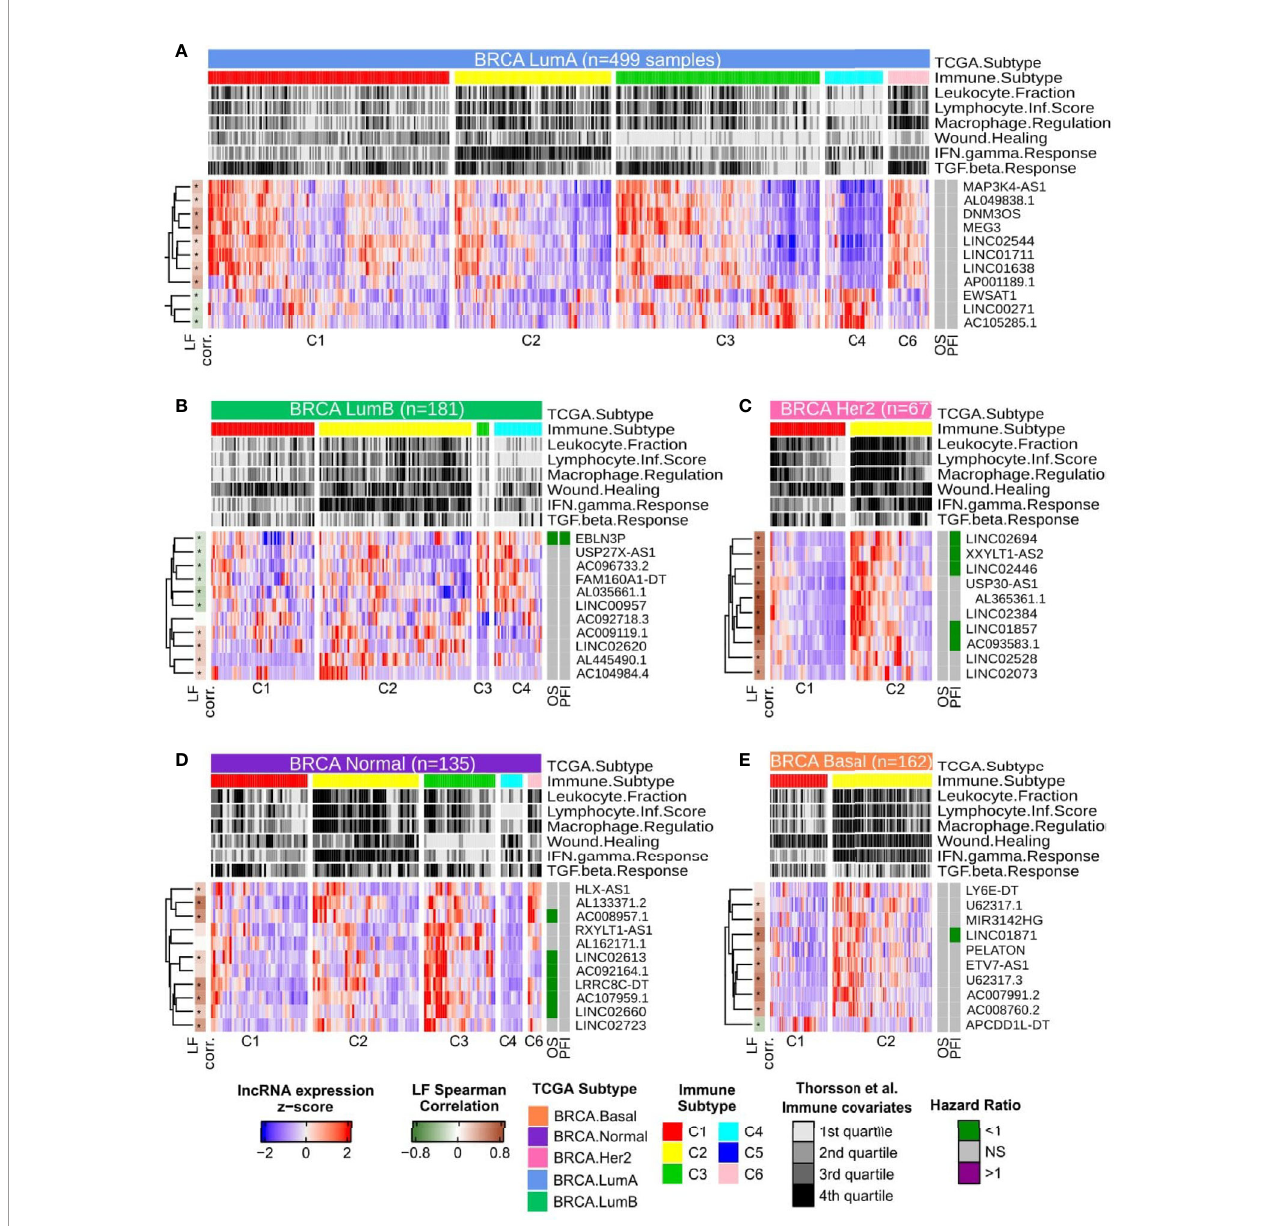
FIGURE 3 | Heatmap with column-wise z-scores for immune related lncRNAs for each BRCA molecular subtype. For color gradient, maximum and minimum z- scores were set to +2 and − 2 respectively. Each column represents a sample and were semi-supervised clustered within the immune subtypes. Immune subtypes groups with less than 5 patients are not represented as they were not used in SNR calculation. The top annotations present the molecular subtype with the number of samples, the immune subtype and the immune covariates as described by Thorsson et al. (8). The immune covariates are presented as quartiles in all TCGA- BRCA primary tumor samples. The left annotation shows the Spearman ’ s correlation for each lncRNAs with Leukocyte Fraction, being dark green for negative and brown for positive r values, asterisks represent Spearman ’ s correlation adjusted p-values values below 0.05. The right annotation represents the Hazard Ratio (HR) inferred by Cox Univariate analysis for Overall Survival (OS) and Progression Free Interval (PFI). Cox results with adjusted p-values greater than 0.1 are considered non signi fi cant and are colored in grey, otherwise, HR values above 1 are colored purple while HR values below 1 are colored in green. (A) LumA samples. (B) LumB samples. (C) HER2-enriched samples. (D) Normal-Like samples. (E) Basal-Like